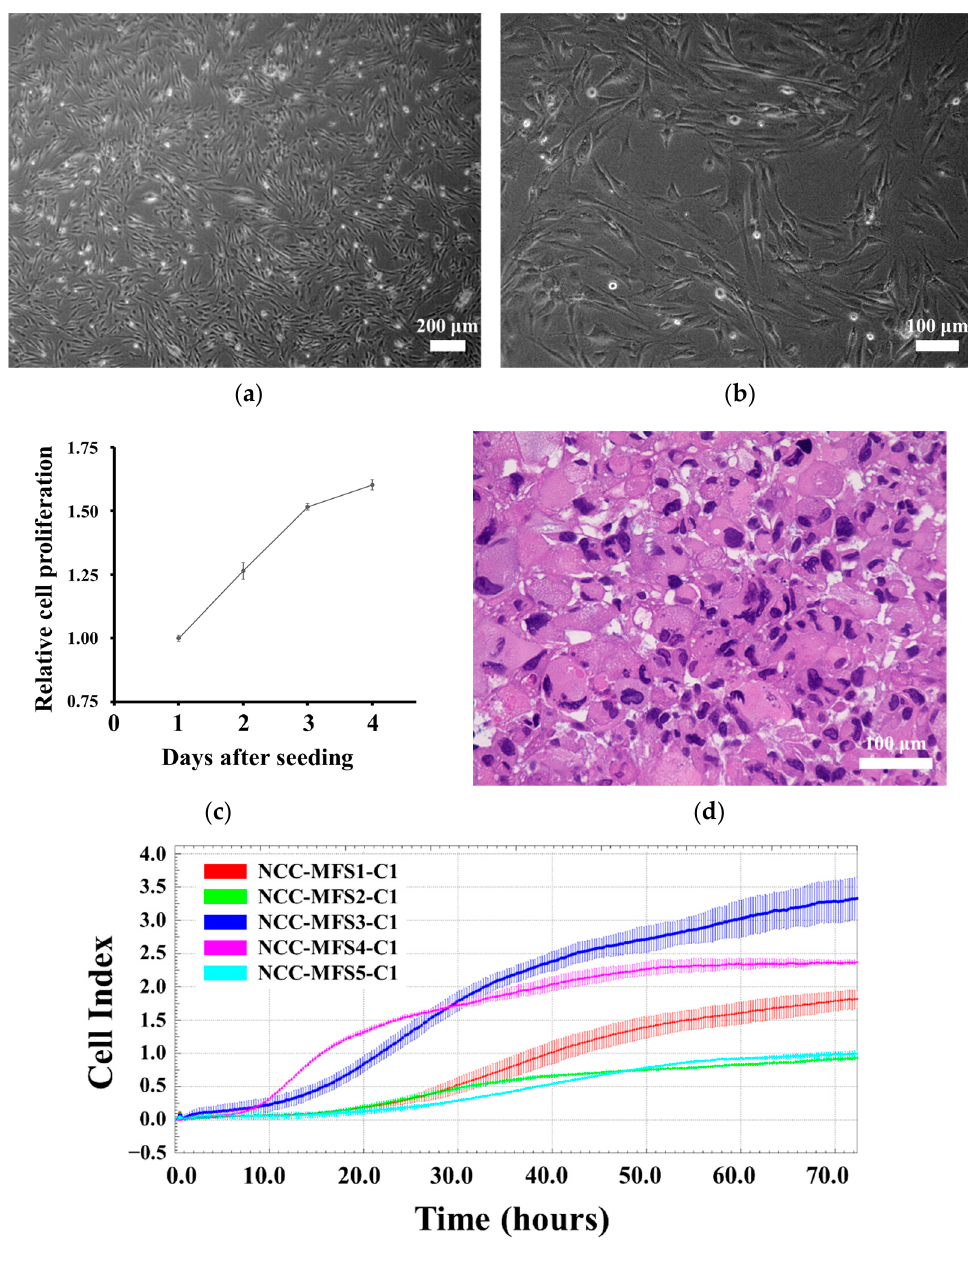
Figure 3. Characterization of NCC-MFS5-C1 cells. ( a , b ) NCC-MFS5-C1 cells exhibiting elongated spindle morphology under 2D culturing conditions. ( c ) Growth curve of NCC-MFS5-C1 cells, showing a constant cell growth. ( d ) H&E section of the spheroid showing pleomorphic oval cells with nuclear atypia. ( e ) The invasiveness of NCC-MFS5-C1 cells compared to that of MFS cell lines we previously established.